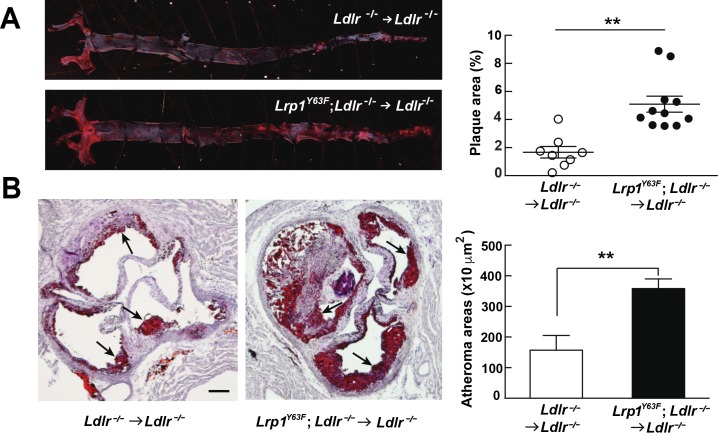
Bone marrow-derived Lrp1Y63F promotes atherosclerosis.(A) Representative images of en face assessment of atherosclerotic lesions in 16 week HCHF-fed recipient mice with indicated bone marrow donor mice (left) and quantification of plaque areas (right). (B) Representative Oil red O-stained sections of aortic roots in each BMT group (left) and quantification of atheroma areas (right). Black arrows indicate atherosclerotic plaque lesions. All data are mean ±SEM. **p<0.01.